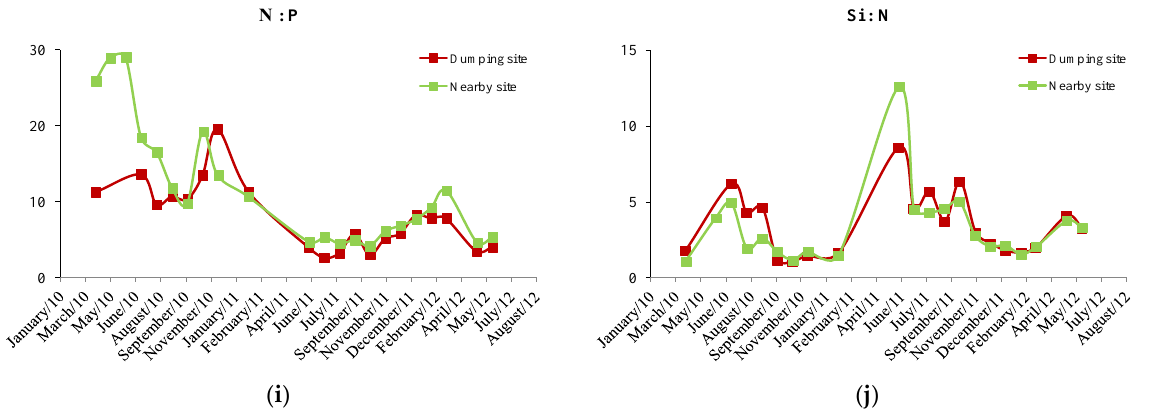
Figure 2. Distribution of temperature ( a ), salinity ( b ), light transmission ( c ), dissolved oxygen ( d ), silicates ( e ), nitrates ( f ), ammonium ( g ), phosphates ( h ), N:P ratio ( i ) and Si:N ratio ( j ) during the monitoring survey for the dredge spoil dumping in coastal waters ( ‘ Dumping site ’ is DSS1,DSS2 and ‘ Nearby site ’ is DSS3, DSS4, DSS5). Values are averaged from surface and bottom.